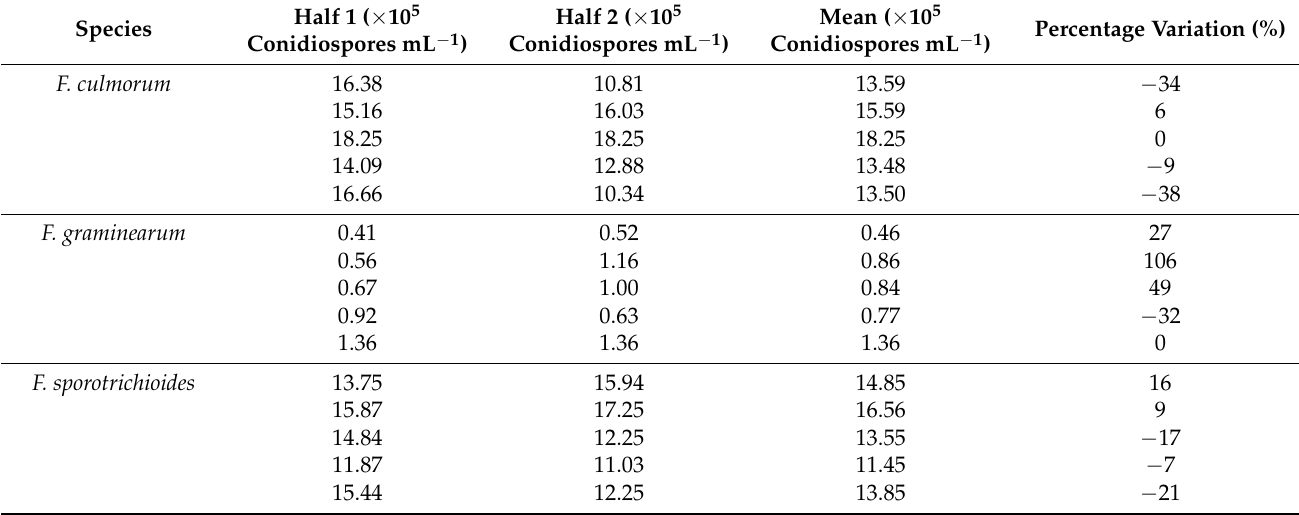
Table 1. Conidiospore concentration distribution on plates for three Fusarium species: F. culmorum , F. graminearum , and F. sporotrichioides . After 14 days of incubation on Synthetic Nutrient-Poor Agar (SNA) plates, spore concentrations were determined using a Thoma counting chamber. The plate was divided, and the two halves were counted separately. This experiment was repeated five times for each species. The percent variation was calculated to indicate the concentration differences between the plates.